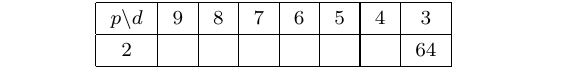
Table 38 . Number of E (8;0) -branes in the p -brane multiplet in d -dimensions. p \ d 9 2240 Table 39 . Number of E (8;3) -branes in the p -brane multiplet in d -dimensions. p \ d 1344 Table 40 . Number of E (9;5) -branes in the p -brane multiplet in d -dimensions. p \ d 560 Table 41 . Number of E (10;3) -branes in the p -brane multiplet in d -dimensions. p \ d 9